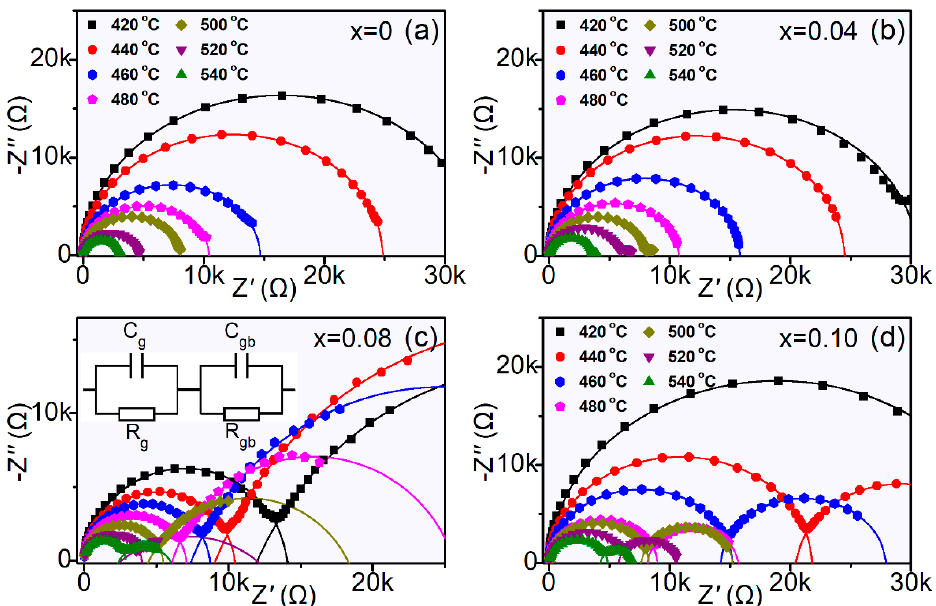
Figure 5. Temperature-dependent complex impedances for KNNS x -BNN ceramics with ( a ) x = 0, ( b ) x = 0.04, ( c ) x = 0.08 and ( d ) x = 0.10 measured at high temperature. Table 2. Temperature-dependent resistance of grain and grain boundary for KNNS x -BNN